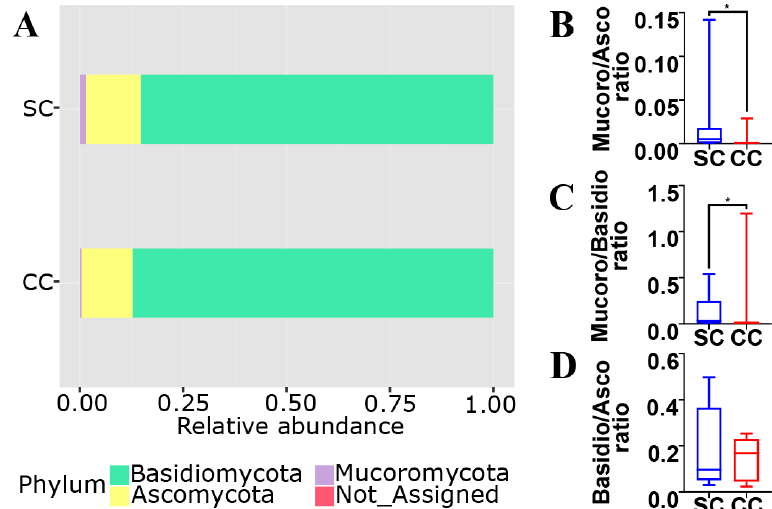
Figure 3. Phylum composition of the mycobiota from SC and CC animals. Panel ( A ) shows that the gut mycobiota of SC animals are mostly represented by Ascomycota (~85.1%), followed by Basidiomycota (~13.3%) and Mucoromycota (~1.5%). These proportions are shifted in the gut mycobiota of CC animals to ~87.2% (Ascomycota), ~12.5% (Basidiomycota), and ~0.4% (Mucoromycota). These values were used to calculate the specific ratios involving the main fungal phyla, between SC and CC animals: Mucoromycota / Ascomycota (Panel ( B )), Mucoromycota / Basidiomycota (Panel ( C )) and Basidiomycota / Ascomycota (Panel ( D )). Results for SC animals are shown in blue, while results for CC animals are shown in red (* = p ≤ 0.05, after Mann–Whitney U test).